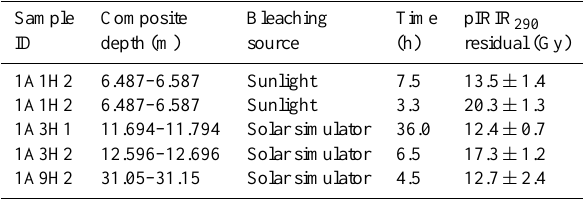
Table 4. Results of the pIRIR 290 bleaching